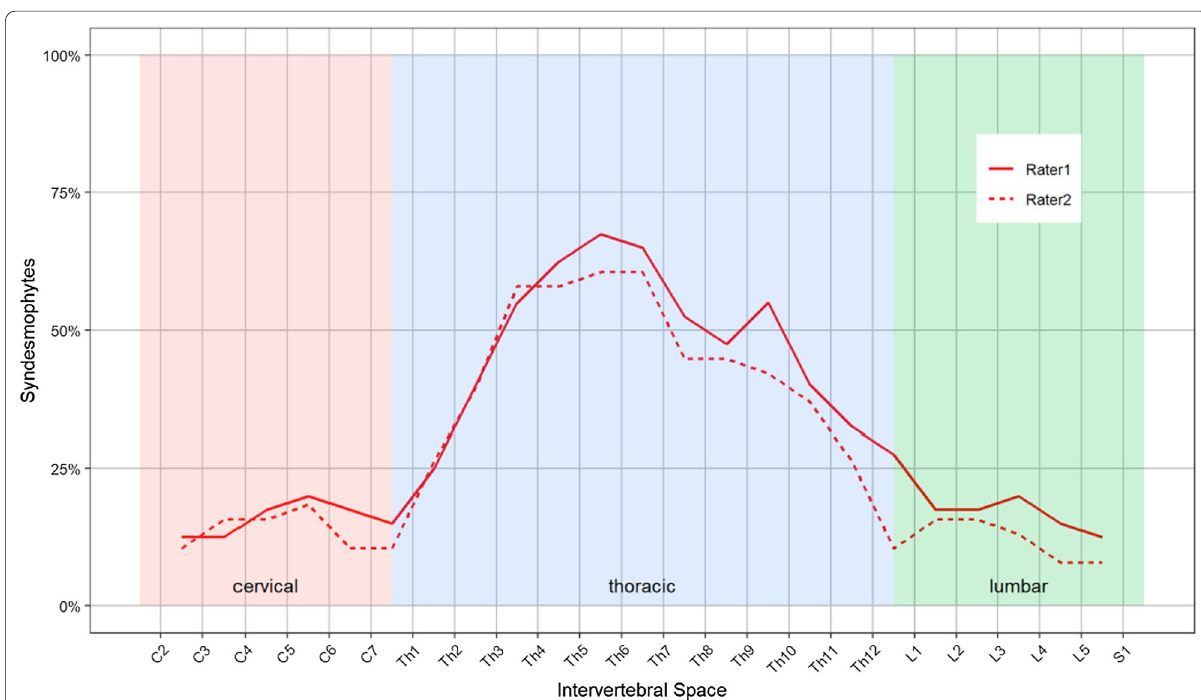
Fig. 3 Frequencies of anterior vertebral syndesmophytes diagnosed with MRI. Syndesmophytes reported on MRI were identified most frequently in the thoracic spine, a vertebral portion that is not considered with